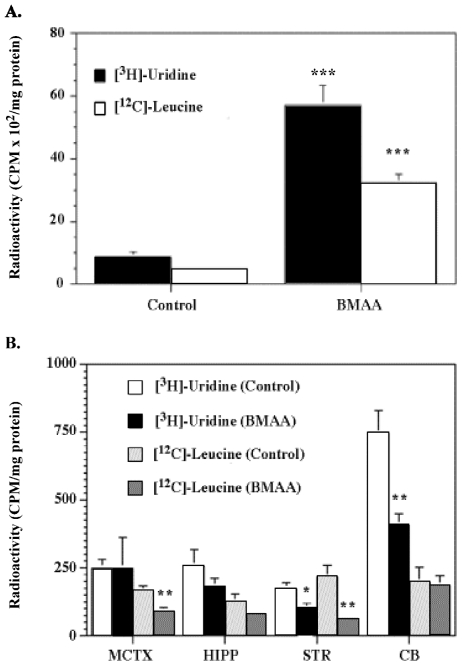
Effect of L-BMAA on rodent brain RNA and protein synthesis. (A) Effect of L-BMAA (24 h) on RNA and protein synthesis in mouse cortical explants 1; (B) Effect of L-BMAA on RNA and protein synthesis in various brain regions of adult rats 2. Graphs derived from unpublished data.1 Explants from the motor cortex of 2-day-old Swiss Albino mice were maintained for 2–3 weeks before treatment for 24 h with 1.6 mM L-BMAA, as previously described by Kisby et al. [40]. Immediately after L-BMAA treatment, the explants were incubated with a solution containing [5-3H]-uridine (19.0 μCi) and L-[1-14C]-leucine (0.95 μCi), the explants washed with buffer, the tissue homogenate fractionated and the supernatant (RNA) and pellets (protein) examined for radioactivity as previously described by Pickard et al. [47]. Values are expressed as CPM/mg protein;2 Adult male rats were administered a single intraperitoneal injection of vehicle (100 mM sodium bicarbonate, n = 8; Control) or L-BMAA (100 mg/kg, n = 8) daily for 14 days. Treated animals were injected intraperitoneally with a mixture containing [5-3H]-uridine (1.7 mCi/kg) and L-[1-14C]-leucine (84 μCi/kg); 30 min later, the brain was excised and dissected into various regions, homogenized and the tissue fractions examined for radioactivity as previously described [47]. Values are expressed as CPM/mg protein. Significantly different from control treated explants or brain tissue (* p < 0.05; ** p < 0.01; *** p < 0.001). MCTX = motor cortex. HIPP = hippocampus. STR = striatum. CB = cerebellum.